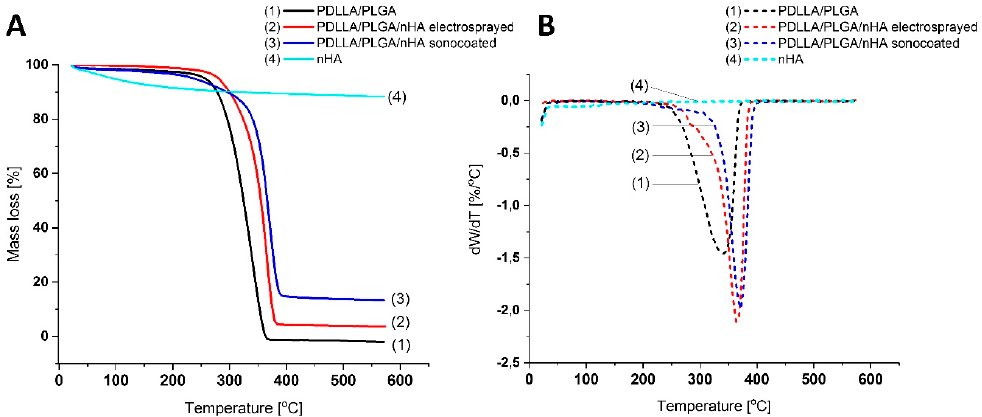
Figure 8. TG ( A ) and DTG ( B ) curves at heating rate b = 10 °C min − 1 of a PDLLA/PLGA (1), PDLLA/PLGA/nHA electrosprayed (2), PDLLA/PLGA/nHA sonocoated, and (3) and nHA (4).